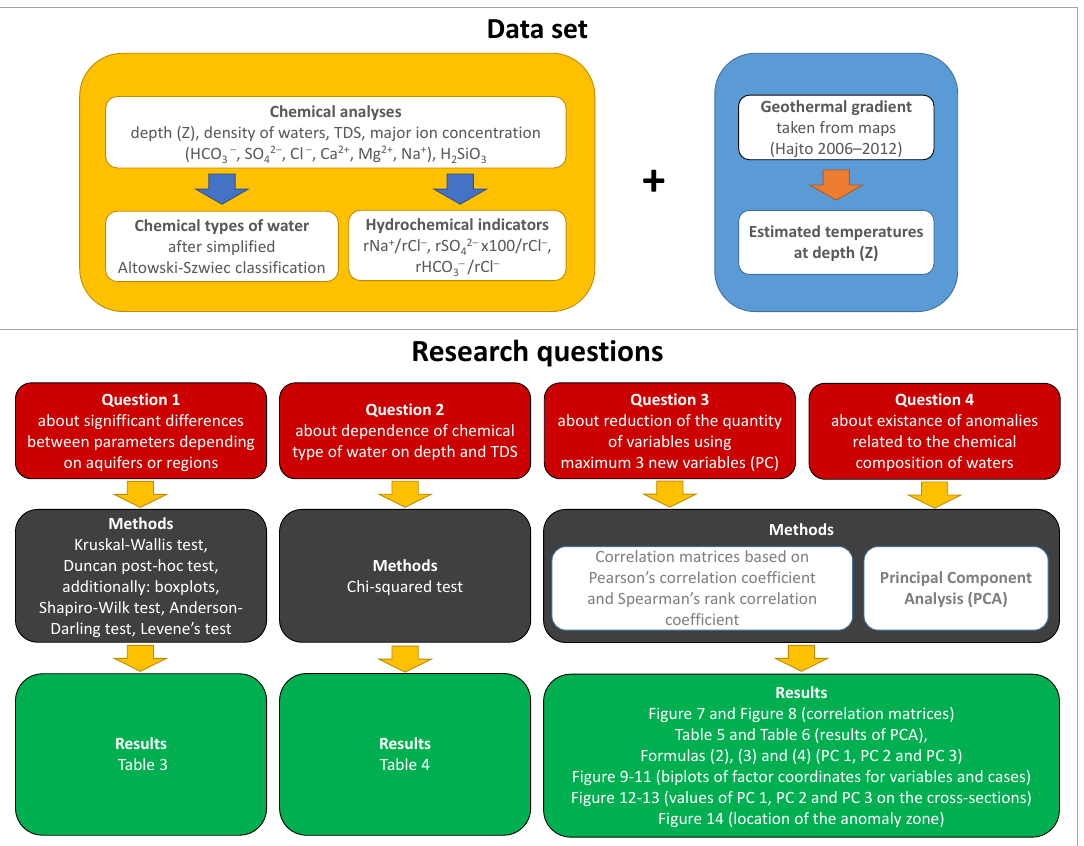
Figure 6. Flow chart presenting the data set, the scienific problems, used statistical methods and where to find the